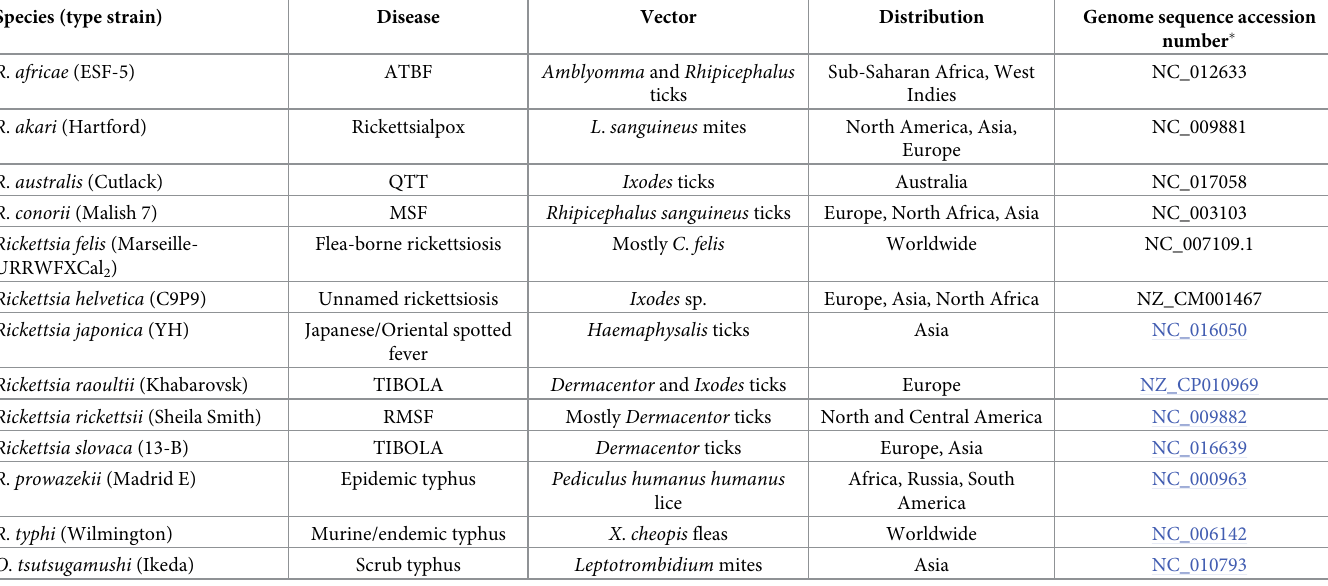
Table 1. Geographical distribution and arthropod vectors of Rickettsia and Orientia species causing CNS